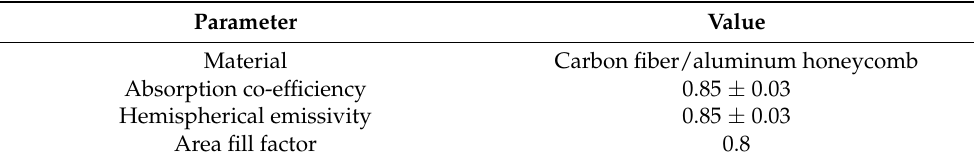
Figure 4. Solar panel structure. Table 2. Solar panel